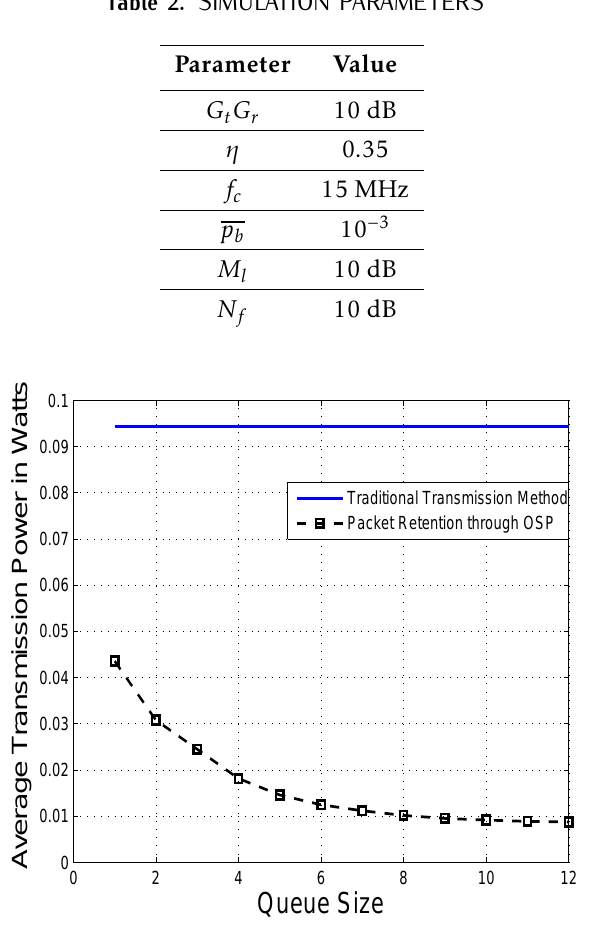
Table 2. SIMULATION PARAMETERS